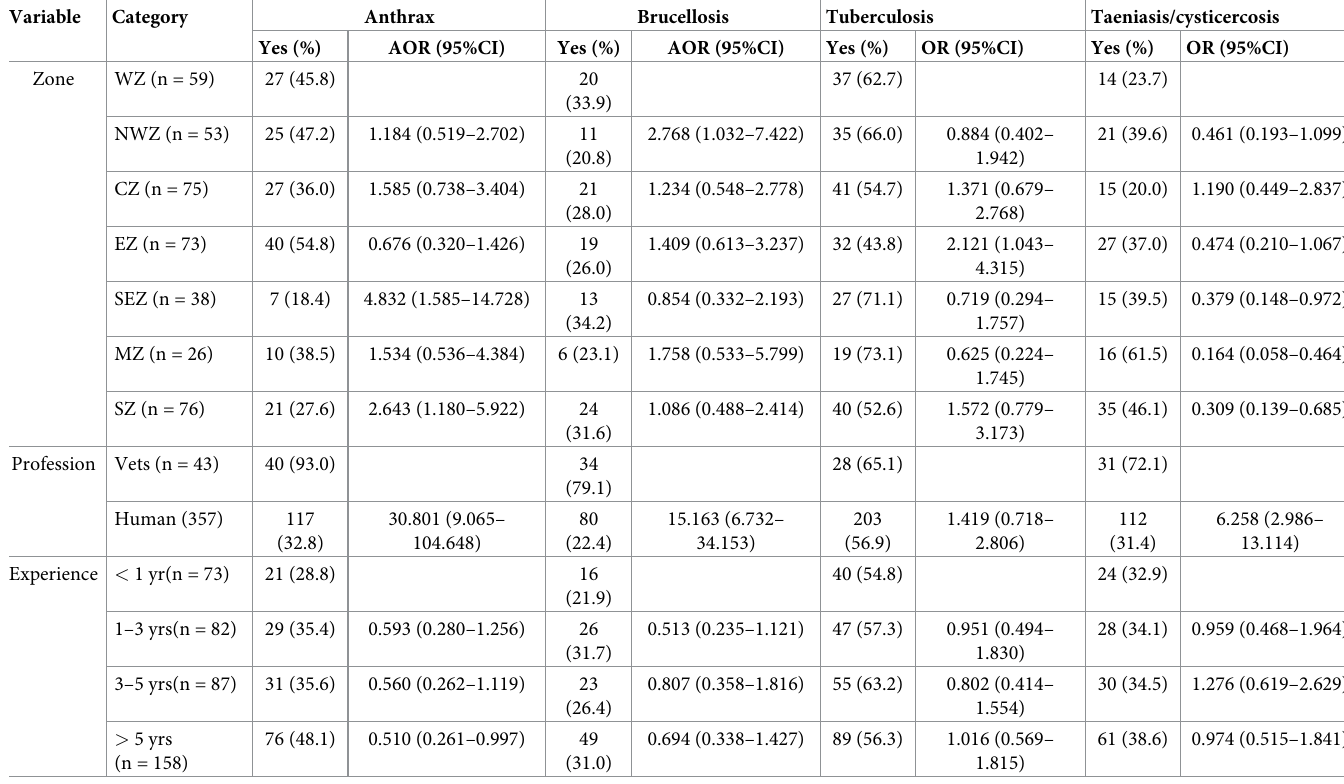
Table 3. Multivariable analysis of anthrax, brucellosis, TB, and taeniasis as major zoonoses against the zone, profession, and work